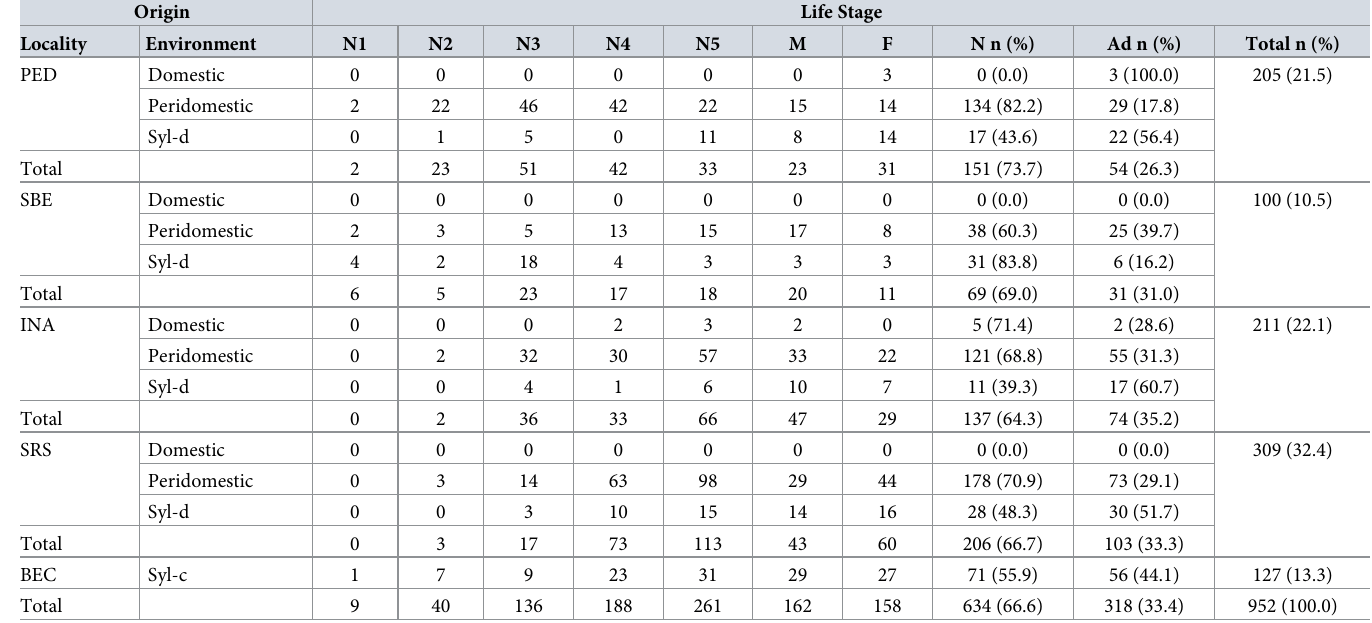
Table 1. Number of Triatoma b . brasiliensis by locality, environment and life stage captured in the Caico´ municipality, Rio Grande do Norte, Brazil. Origin Life Stage